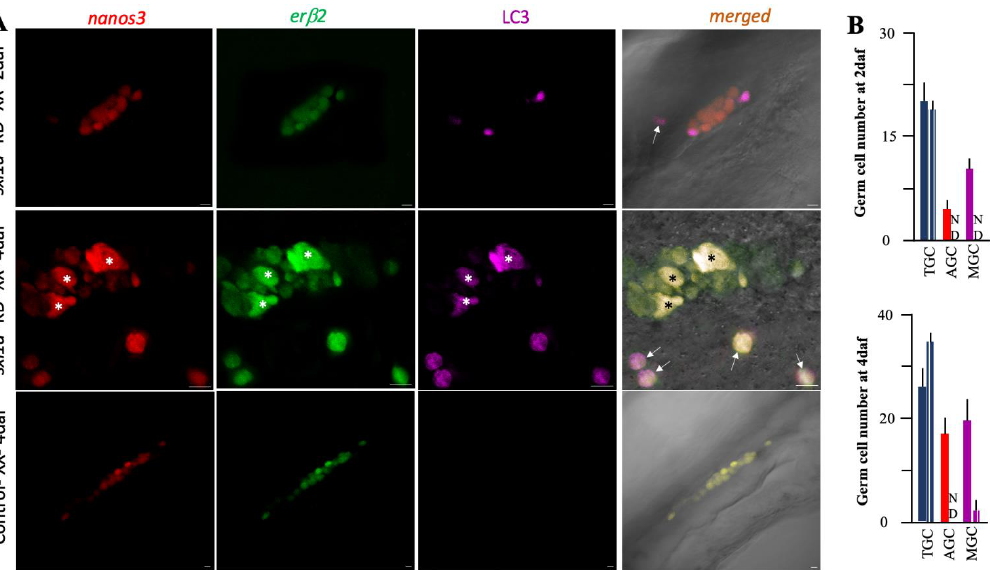
Figure 5. Evaluation of germ cell physiology in sxl1a -KD medaka embryos. The 2 and 4 DAF sxl1a - KD (upper and middle panel, respectively), and control (lower panel) embryos were fixed, and